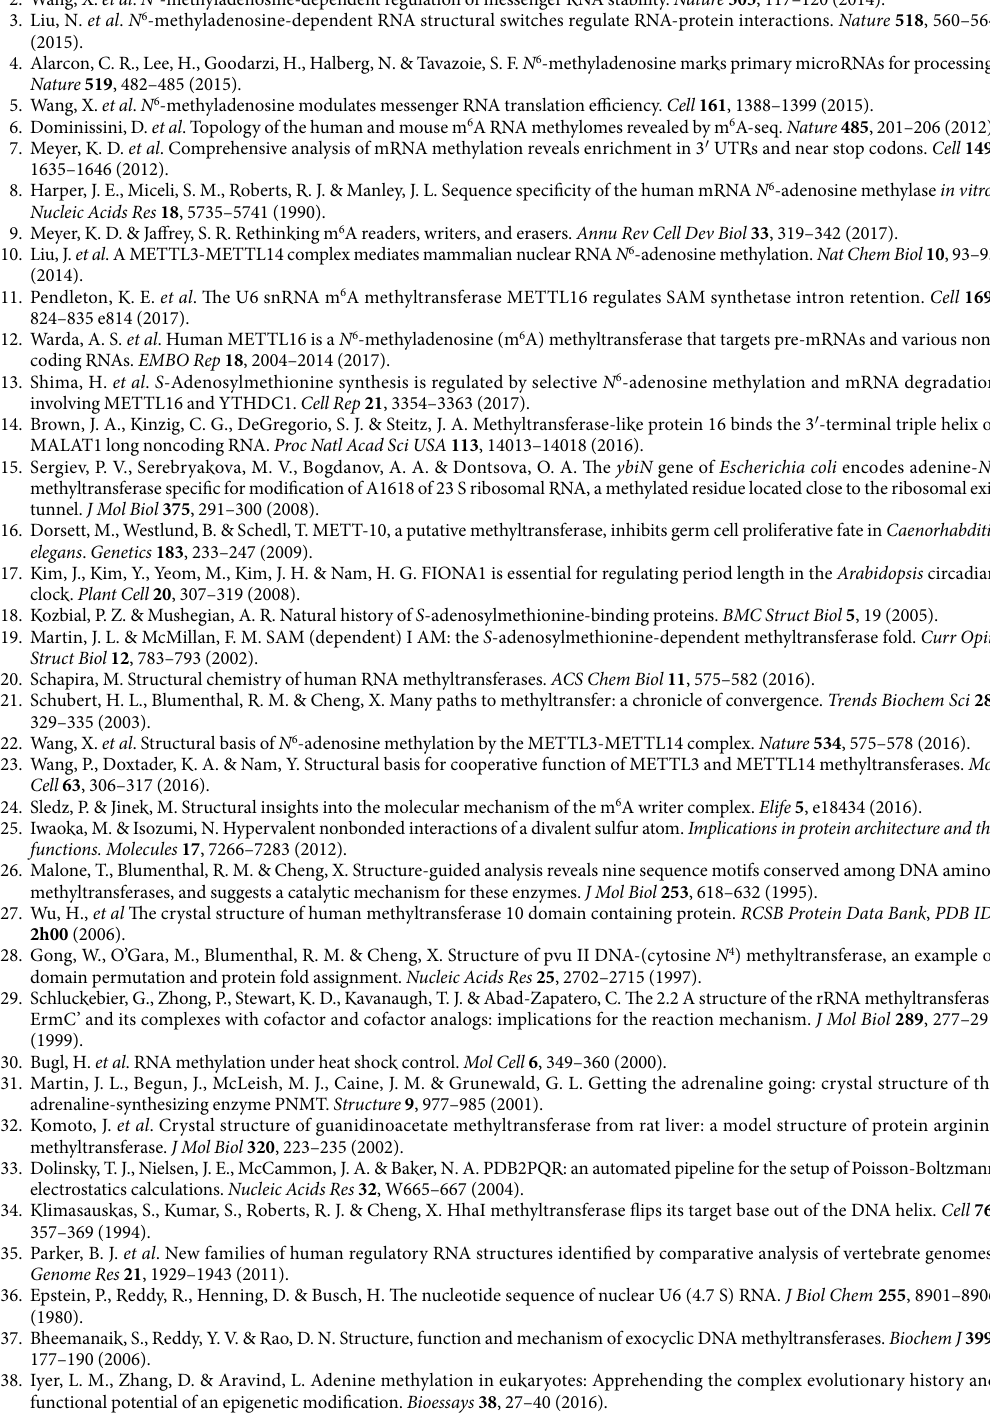
vation calculated using the ConSurf server 69